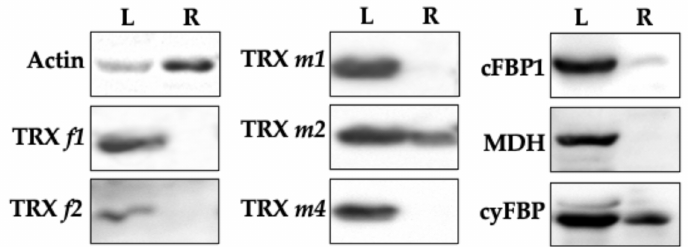
Figure 8. Immunodetection of TRXs m and f and targets cFBP1 and MDH in leaves and roots of Arabidopsis plants. L, leaves; R, roots. cyFBP (cytosolic FBPase) was included in the Western blotting analyses as a positive control of root expression. Tissues of 21-day-old plants were analysed.